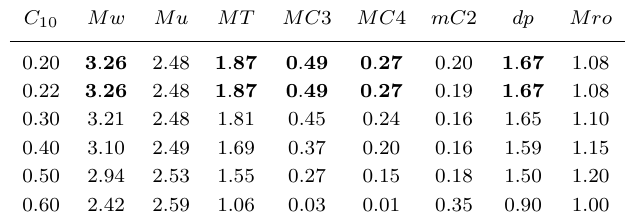
Table 1. Values of Mw,Mu,MT,MC 3( H 2 O ) ,MC 4( CO 2 ) ,mC 2( O 2 ) ,dp,Mro versus C 10 C 10 Mw Mu MT MC 3 MC 4 mC